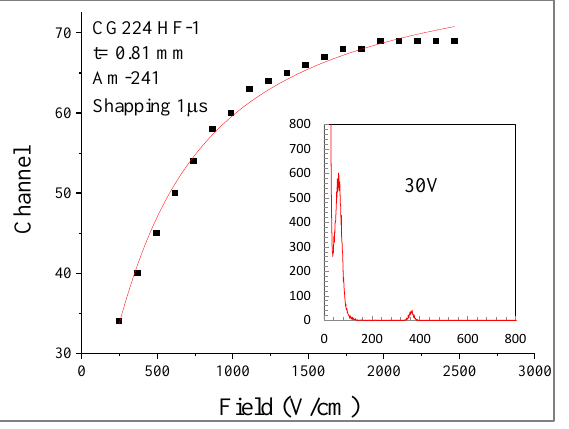
Figure 11. µτ e -measurements (1.0 × 10 −4 cm 2 /V) and gamma response to 241 Am for CRY-1.